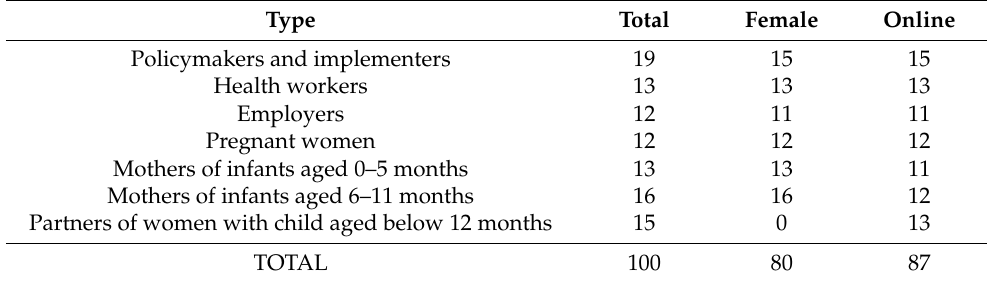
Table 1. Number of in-depth interview participants by gender and data collection